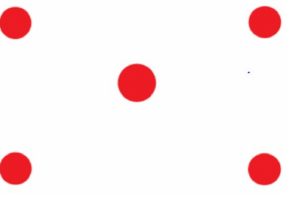
Figure 13. Five-point pattern used in the robustness test. Table 3. Robustness results for gaze